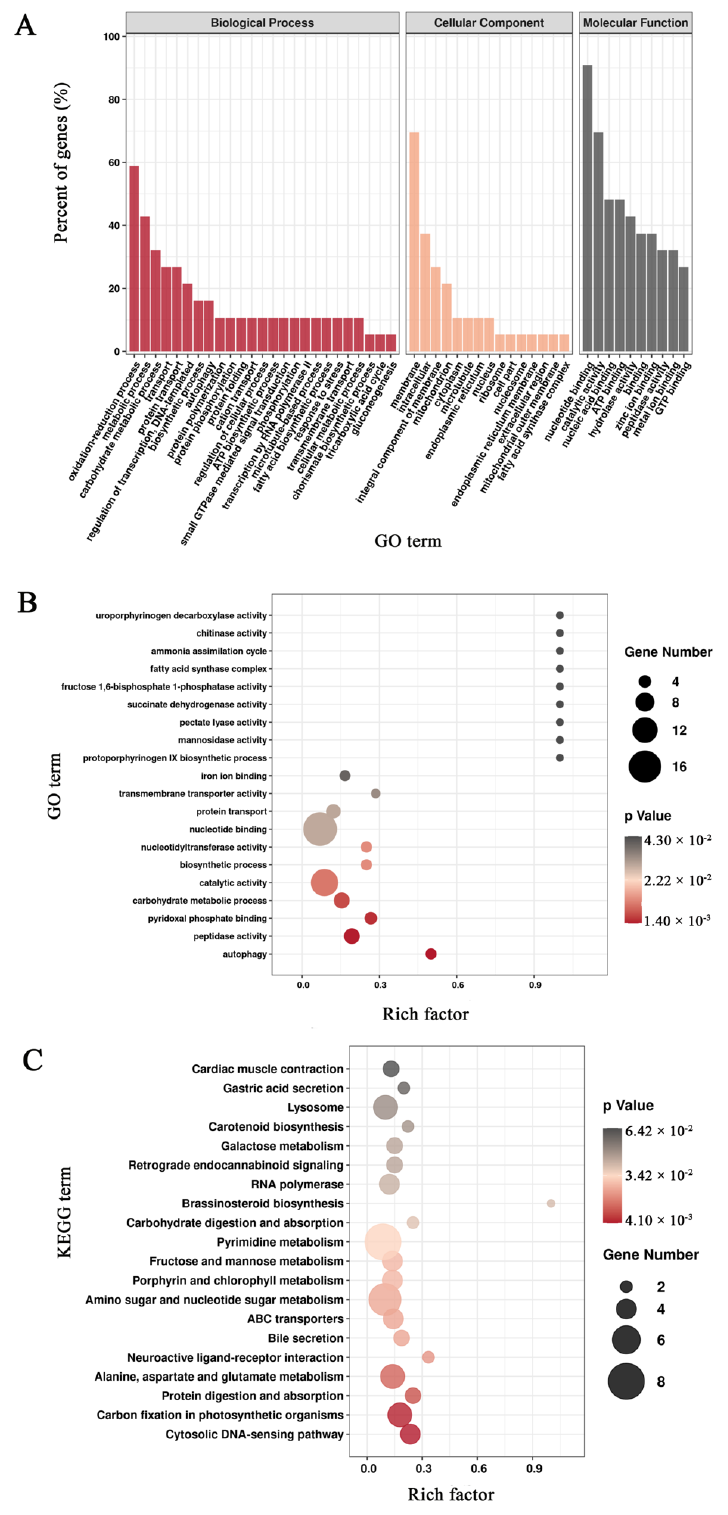
Figure 5. GO ( A , B ) and KEGG ( C ) enrichment analyses of differentially expressed genes (DEGs) derived from the TA vs. TB comparison of Mortierella alpina .